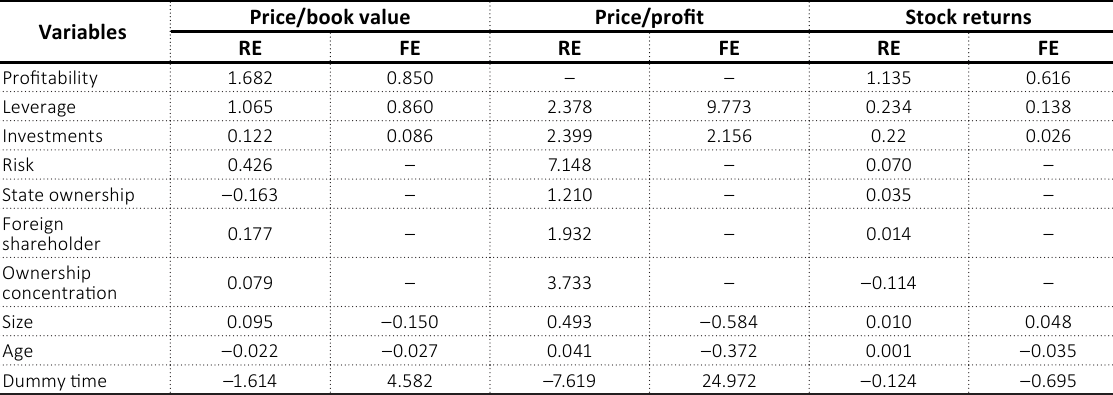
Table 1. Evaluation of drivers and factors of company value